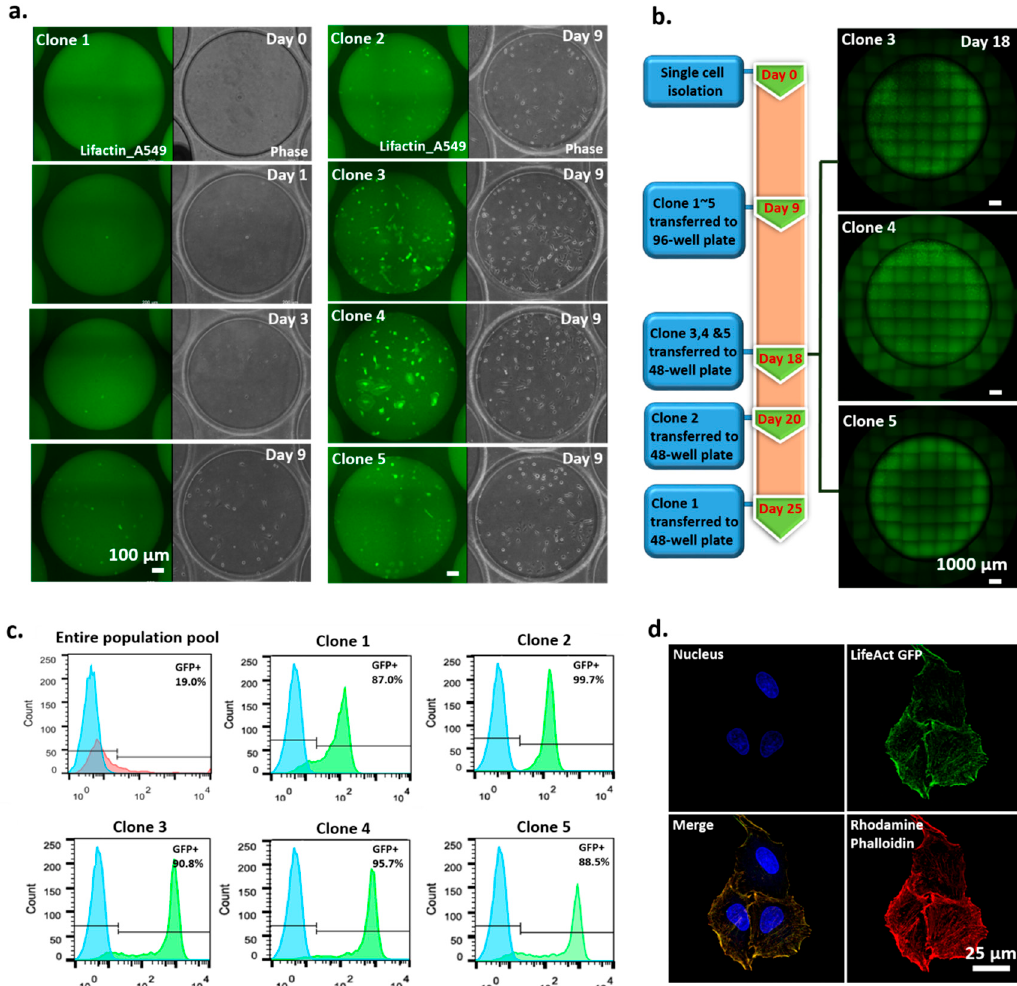
Figure 5. Clonality-validated monoclonal cell lines established by an SCC device. ( a ) Time-course images of single-cell-derived clone 1 (left) and images of single-cell-derived clones 2–5 at 9 days (right). ( b ) Timeline of how clonality-validated monoclonal cell lines are obtained. ( c ) Analysis of GFP expression level of monoclonal cell lines by FACS. ( d ) Verified colocalization of LifeAct-GFP and rhodamine phalloidin.